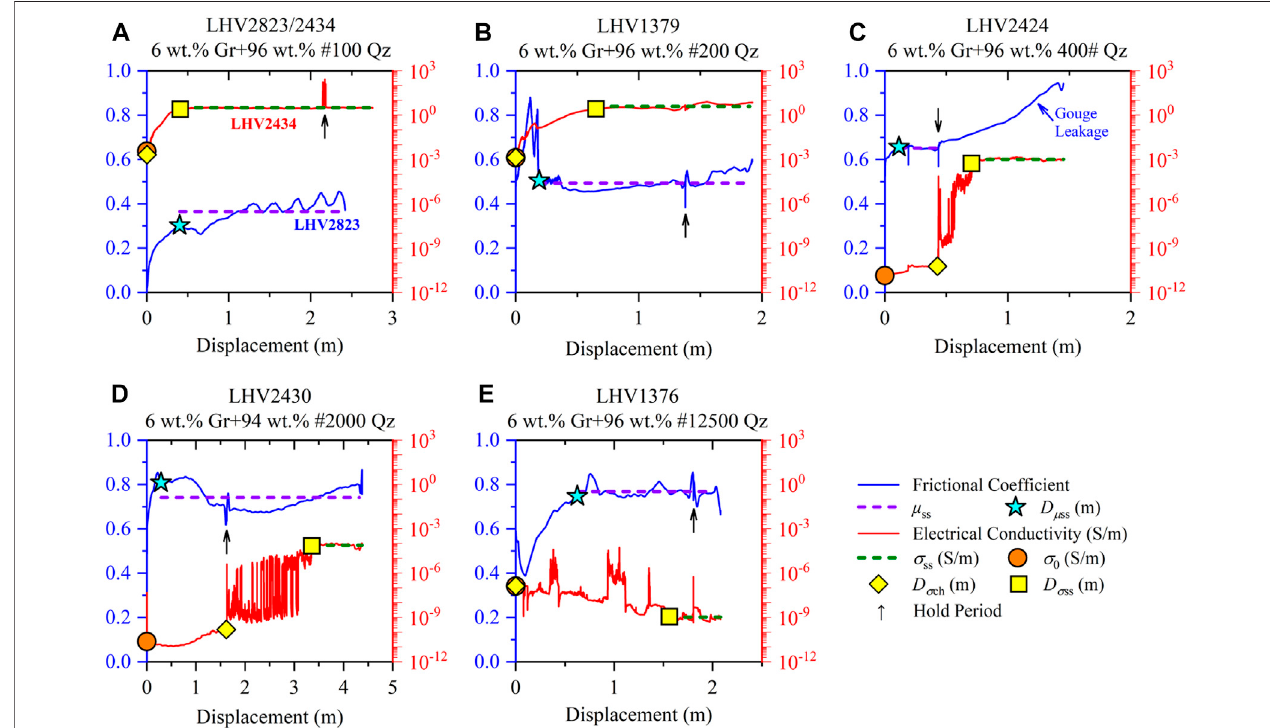
FIGURE3| Frictionalcoef fi cient(solidblueline)andelectricalconductivity(solidredline)plottedagainstslipdisplacementforallspecimens.TheparticlesizesofQz particles include (A) #100 mesh, (B) #200 mesh, (C) #400 mesh, (D) #2000 mesh, and (E) #12500 mesh.